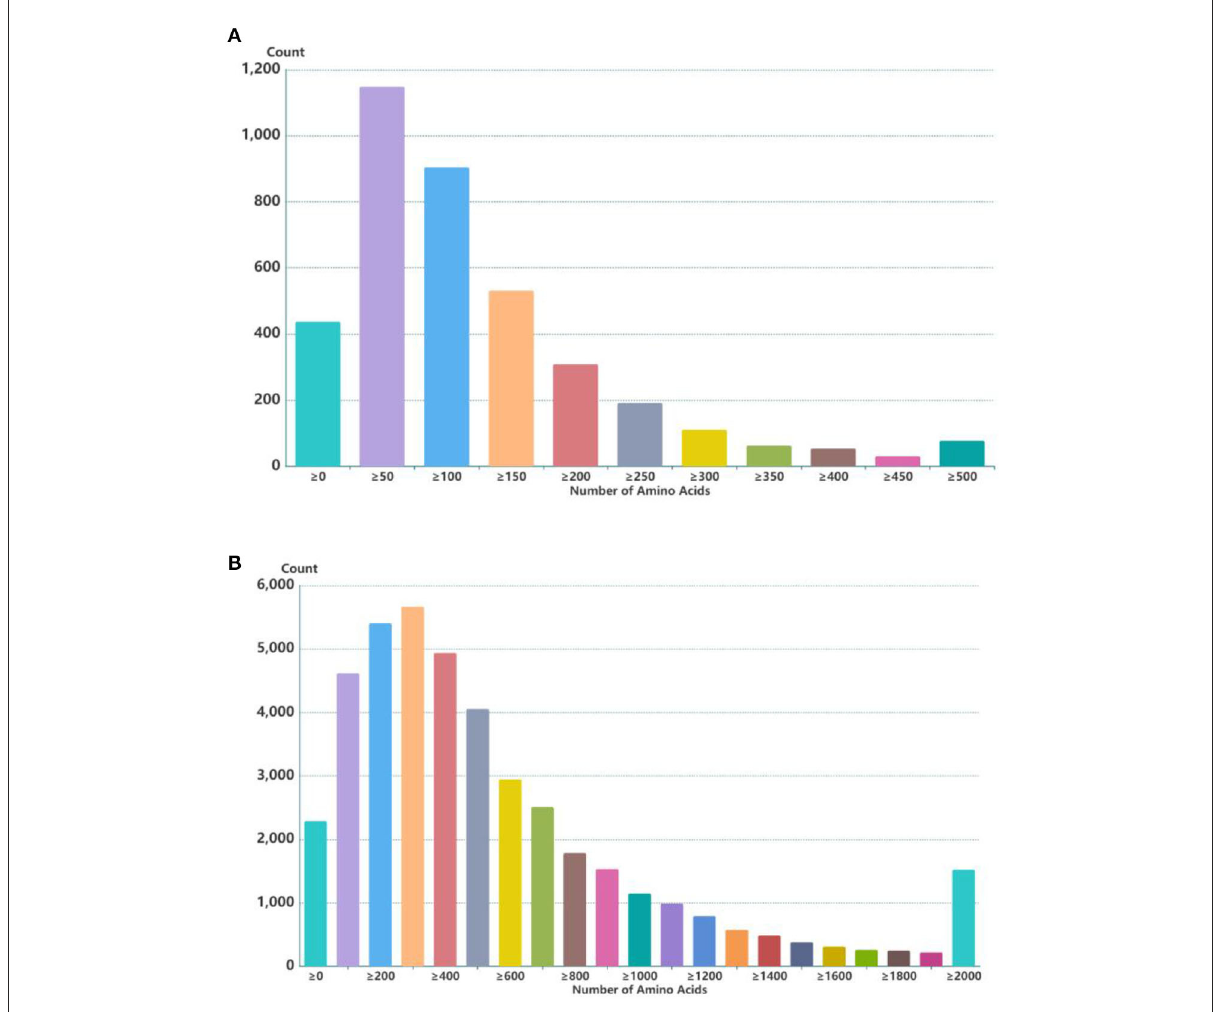
FIGURE2 ORF length statistics of lncRNA and mRNA in embryonic hair follicles of Inner Mongolia cashmere goats. (A) ORF length of lncRNA. (B) ORF length of